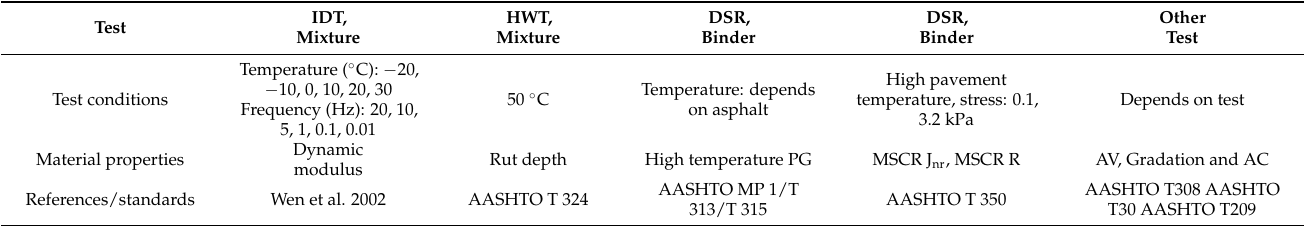
Table 2. Summary of Laboratory Mixture and Binder Testing.